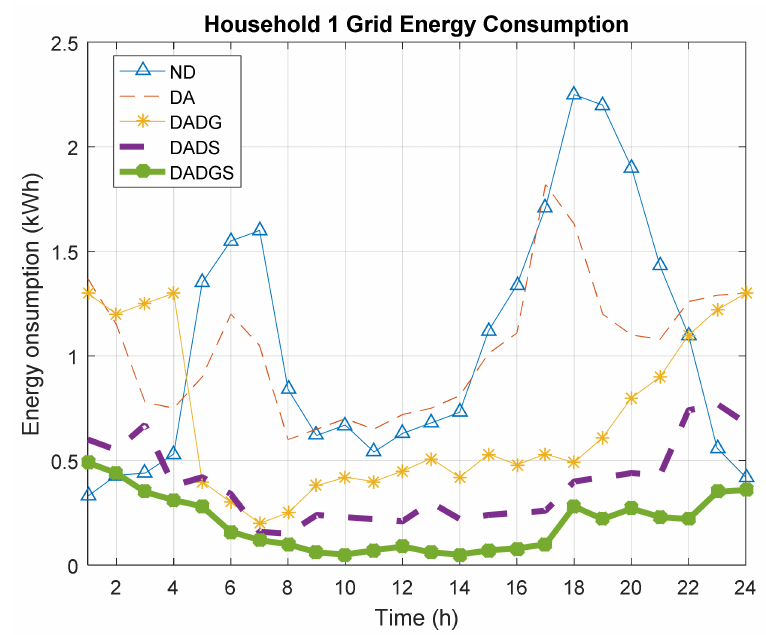
Figure 4. Average grid energy consumption for Household